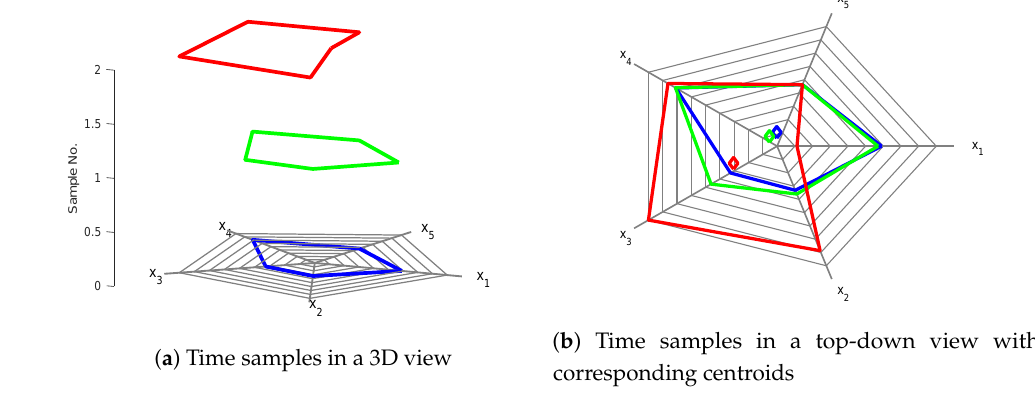
Figure 4. The centroid of each slice constitutes a single-point, multivariate representation of each data slice. ( b ) is a “top-down” view of ( a ), with the centroids shown as